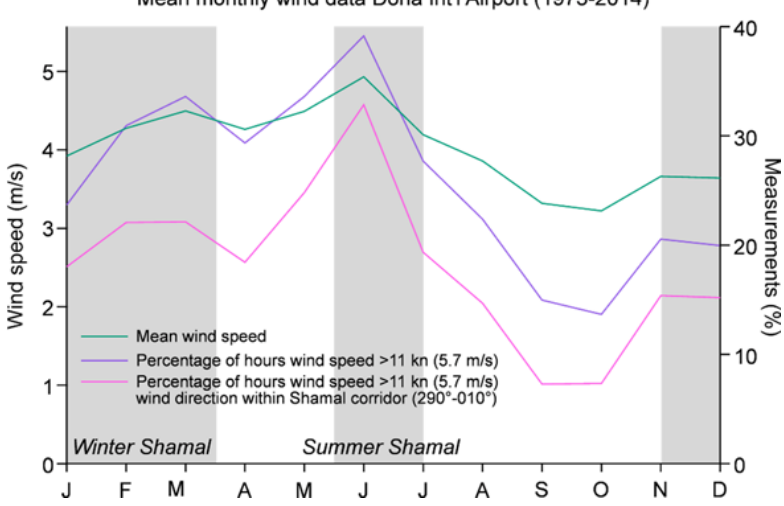
Figure 2. Monthly distribution of mean wind speed, general percentage of hours of wind speed >11 kn, and percentage of hours of wind speed >11 kn within the Shamal corridor (290°–010° deviation from N) at Doha International Airport [12], the longest serving climate station in Qatar.